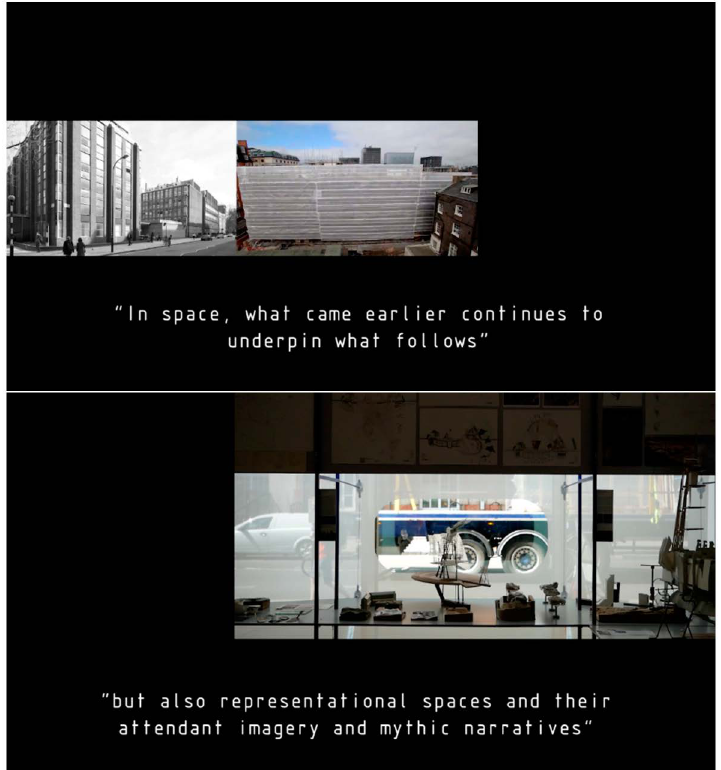
Screen grabs from the short film, The Death and Life of UK Universities (Source: c (cid:13) Igea Troiani and Tonia Carless, 2020). The top screen grab includes a photograph of Wates House (1975–2014) at UCL (foreground), and a photograph of the building under reconstruction (into what is now 22 Gordon Street). The bottom screengrab shows onsite footage shot by the authors looking outside from the ground floor interior of 22 Gordon Street during the Bartlett’s 2019 End of Year Show, and the narrative overlay of quotation that ‘Nothing disappears completely’ from Henri Lefebvre’s The Production of Space